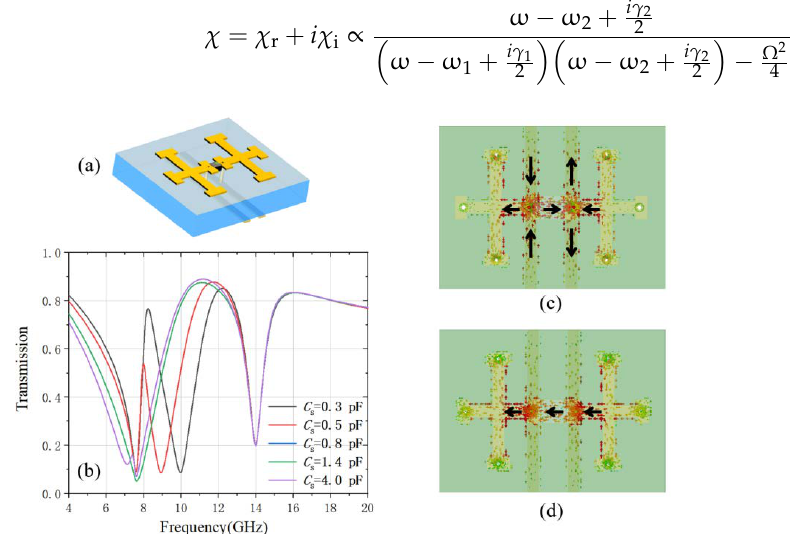
Figure 4. ( a ) the schematic of the double-cross, varactor diode and strip line unit cell; ( b ) its x-polar- ized transmission at different varactor diode capacitance; ( c ) the surface current of the transmission peak at 8.5 GHz when the diode capacitance is 0.3 pF and ( d ) the surface current of the transmission peak at 7.6 GHz when the diode capacitance is 1.4 pF.